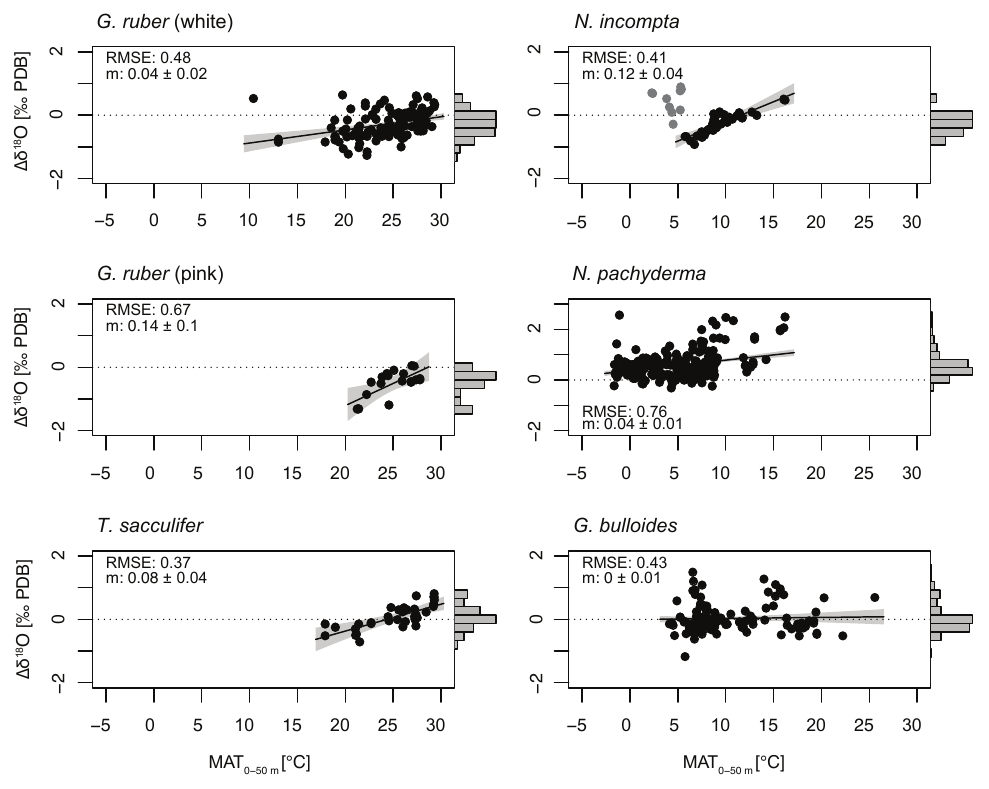
Figure 2. Temperature-dependent offsets between predicted annual mean near-surface and observed δ 18 O ( (cid:49)δ 18 O annual . mean ), suggesting habitat tracking. All species except G. bulloides show a trend in (cid:49)δ 18 O annual . mean values with mean annual temperature in the upper 50m (MAT 0 − 50m ) of the water column suggesting that planktonic foraminifera adjust their habitat to minimise temperature change in their environment. Histograms show the spread in the (cid:49)δ 18 O annual . mean values. The root mean square error (RMSE) and the linear slope ( m ± 90% confidence interval) of the (cid:49)δ 18 O–temperature relationship are indicated in the upper left corner of each panel. The uncertainty envelopes depict the 5th to 95th percentile of the uncertainty on the MAT– (cid:49)δ 18 O annual . mean relationships, which are indicated by the solid black line. The grey dots in the panel for N. incompta show the data that are excluded from further analyses as they most likely stem from right-coiling morphotypes of N. pachyderma